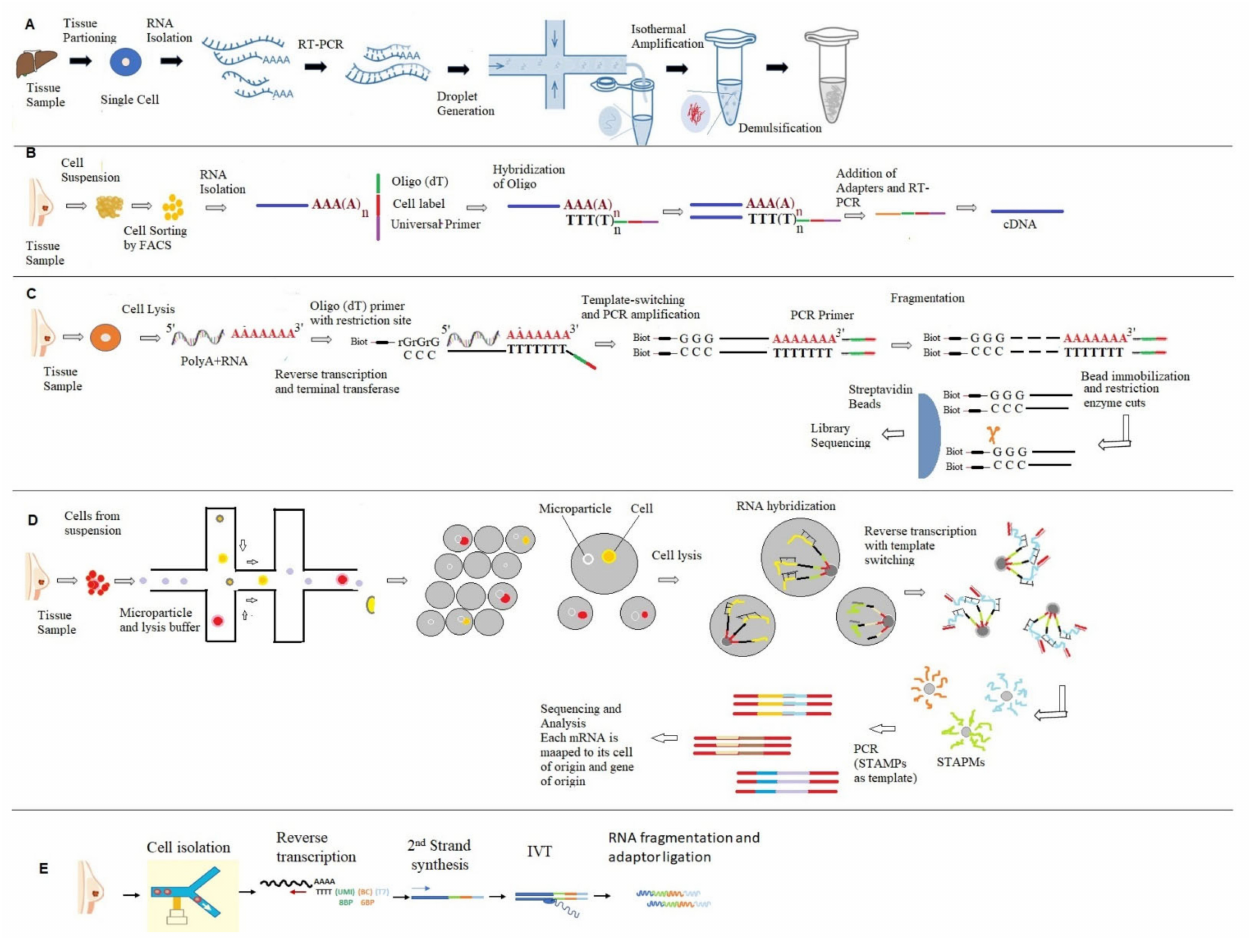
Figure 3. Shows different types of RNA-seq techniques used for the analysis of RNA from cancer tissues. ( A ) depicts cell expression by linear amplification and sequencing method; ( B ) displays single-cell RNA barcoding and sequencing (SCRB-seq) approach; ( C ) displays steps involved in switching mechanism at the end of the 5 (cid:48) -end of the RNA transcript sequencing (Smart-seq2), ( D ) represents various steps used for the analysis of transcripts by Drop-sequencing (Drop-seq), and ( E ) shows various steps involved in the Massively Parallel RNA Single-Cell Sequencing Framework